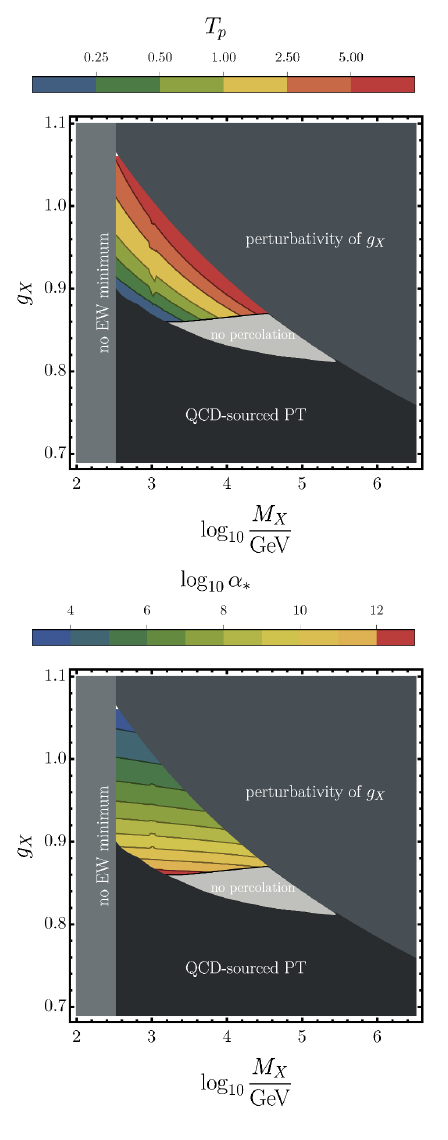
Figure 20 . Results of the scan with fixed renormalisation scale, µ = M X (left column), µ = M Z (right column) for selected parameters characterising the phase transition: percolation temperature T p (upper row), log α ∗ (lower 10